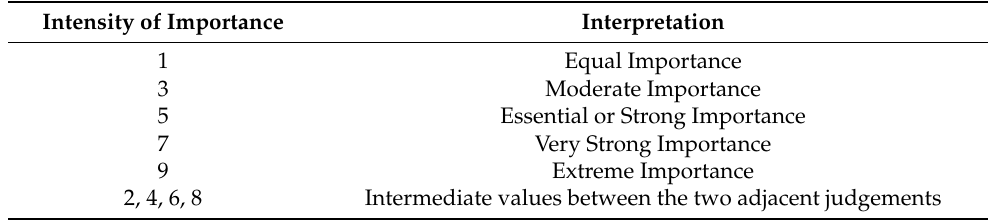
Intermediate values between the two adjacent